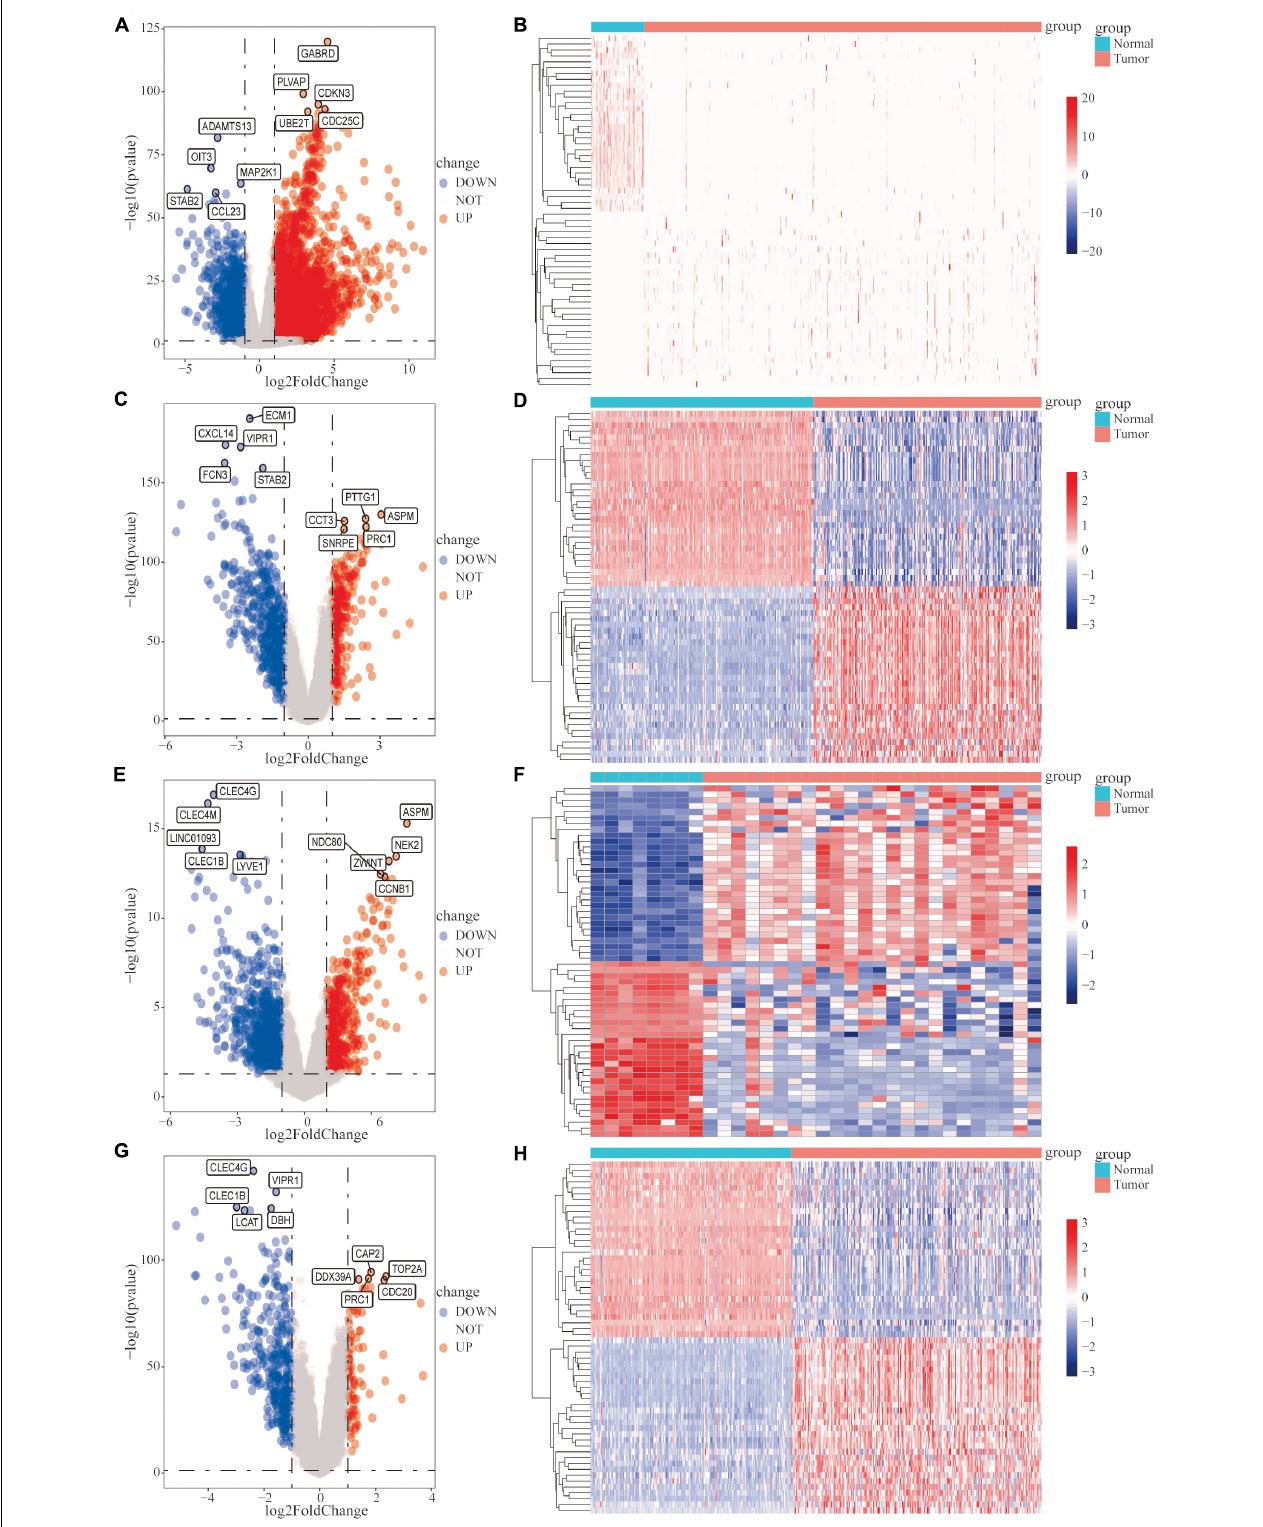
FIGURE 1 | Analysis of differentially expressed genes (DEGs) between hepatocellular carcinoma (HCC) tumor tissues and adjacent normal tissues. Differential expression analysis was performed, based on the gene expression data for HCC patients, and the analysis results are presented as volcano plots and heat maps. (A,B) The cancer genome atlas (TCGA)-HCC dataset, (C,D) GSE14520 dataset, (E,F) GSE101685 dataset, and (G,H) GSE36376 dataset.